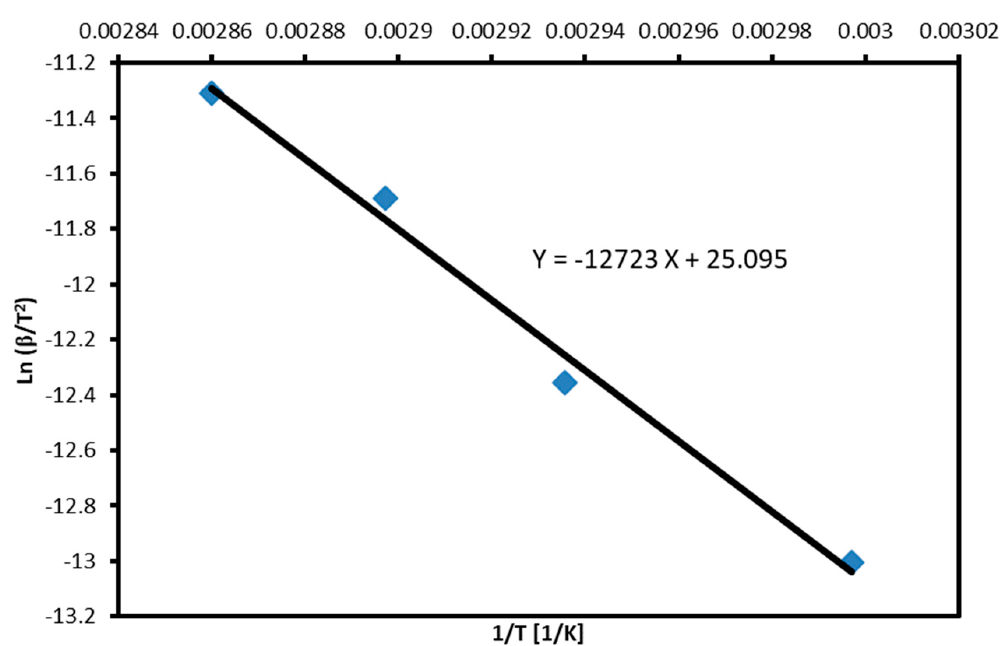
Figure 5. Plot of (cid:1864)(cid:1866) (cid:2010) (cid:1846) (cid:3042)(cid:2870) ⁄ versus the inverse of the absolute temperature according to Kissinger Figure 5. Plot of ln β / T 2 o versus the inverse of the absolute temperature according to Kissinger method.